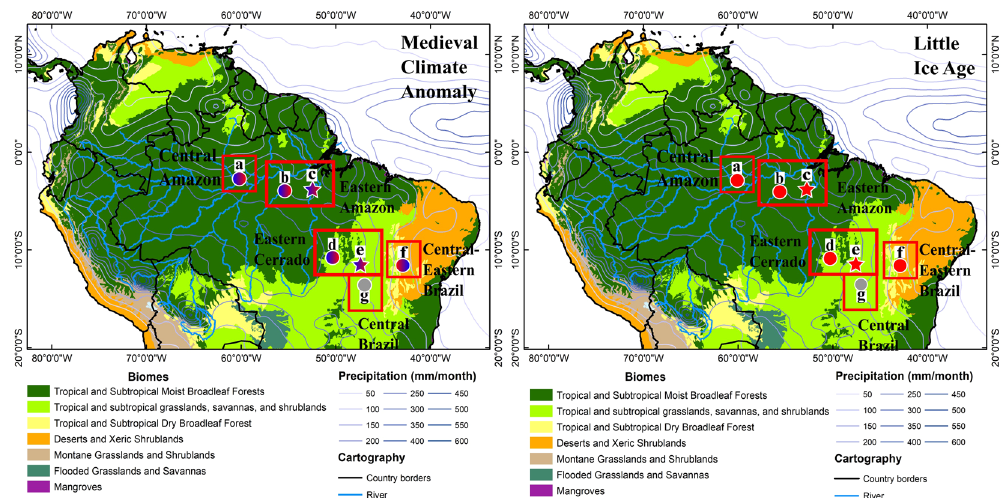
Figure 1. Shaded terrestrial ecoregions 65 and DJF contoured climatological precipitation in mm/month for the period from 1998 to 2017, with data from TRMM 3b43 66 . The difference between the two scenarios, MCA and LIA, are shown by different color schemes representing the following climate conditions: red - dry; blue-to-red – transition from humid to dry; red-to-blue – transition from dry to humid; grey – neutral conditions. Records are: ( a ) Paredão archeological sites 44 ; ( b ) Paraíso Cave 9 ; ( c ) Arapujá Lake (this study); ( d ) Bananal Island 56 ; ( e ) Mata Virgem Cave (this study); ( f ) DV2 record 53 ; ( g ) SBE3/SMT5 records 16